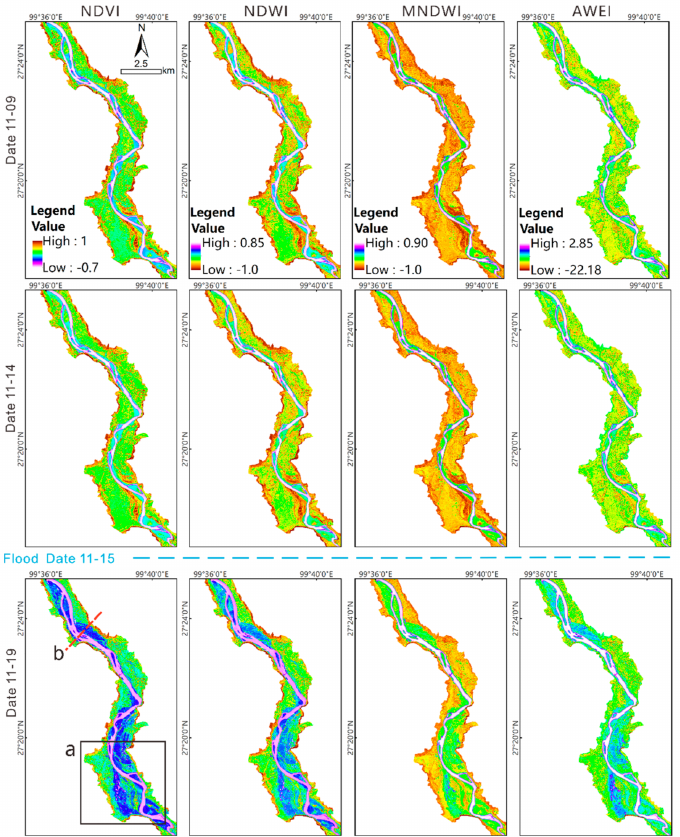
Figure 5. The Sentinel-2 four spectral indices. The time series were from 11.09 to 11.19. From left to right, are NDVI, NDWI, MNDWI, AWEI, respectively. From top to bottom are observation dates 11.09, 11.14 and 11.19 in order; The blue dashed line between images on 11.14 and 11.19 indicates the flood occurred date was 11.15. Line b is the river section location in Figure 6 and rectangular a is the test area of Figure 7.